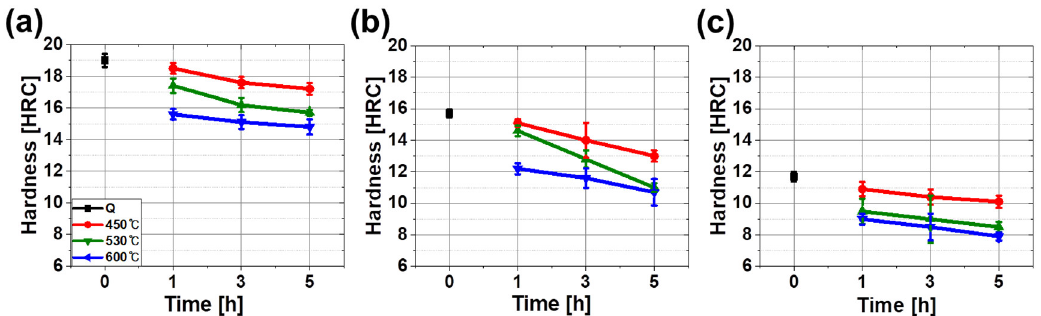
Figure 8. Hardness of ( a ) FC (−10.6 °C/s), ( b ) MC (−4.6 °C/s), ( c ) SC (−2.5 °C/s) specimens according to the tempering conditions. Tempering conditions represented in black, red, green and blue mean quenching, 450, 530 and 600 °C, respectively.